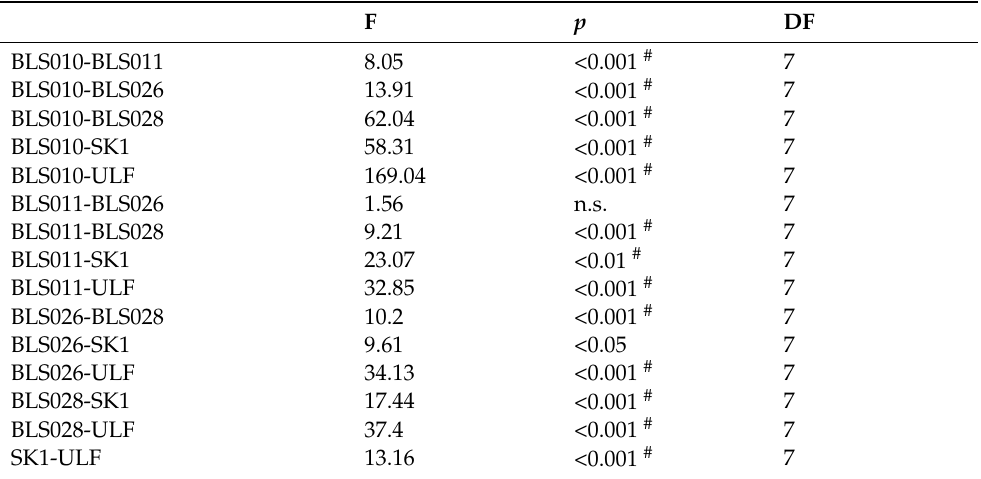
Figure 4. Linear discriminant (LD) analysis plot for individual identification of howls from Eurasian wolves with a 92% correct classification. Table 6. Pairwise post-hoc Hotelling test for Arctic wolves with F-values, p -values and number of degrees of freedom (DF). Symbol # indicates significant p -values after sequential Bonferroni. n.s. indicates not significant p